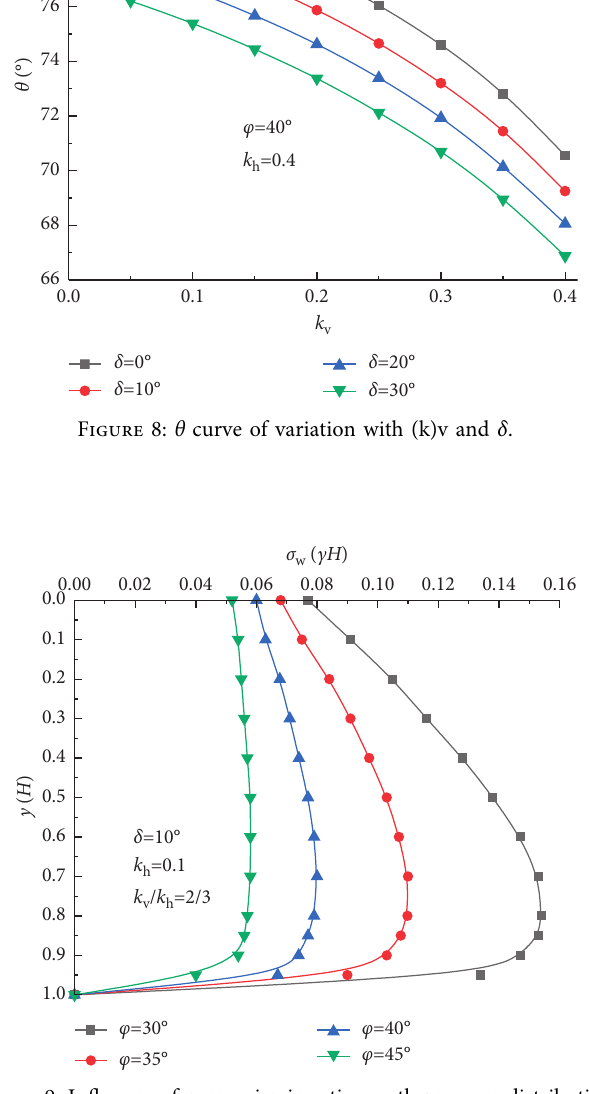
Figure 9: Influence of φ on seismic active earth pressure